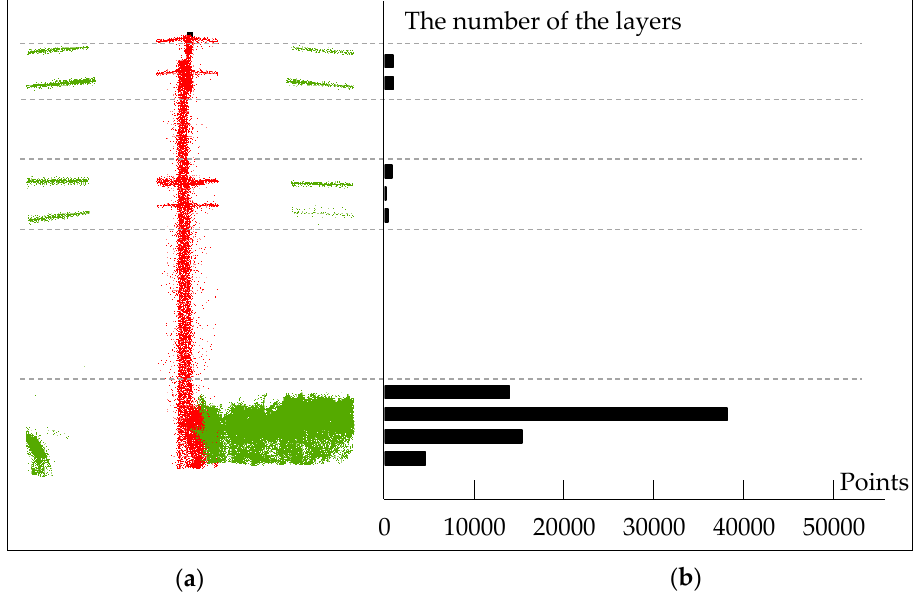
Figure 4. Buffer and layer-by-layer point statistics: ( a ) point cloud of telegraph poles and the buffer area; ( b ) the total number of points on each layer in the buffer area.